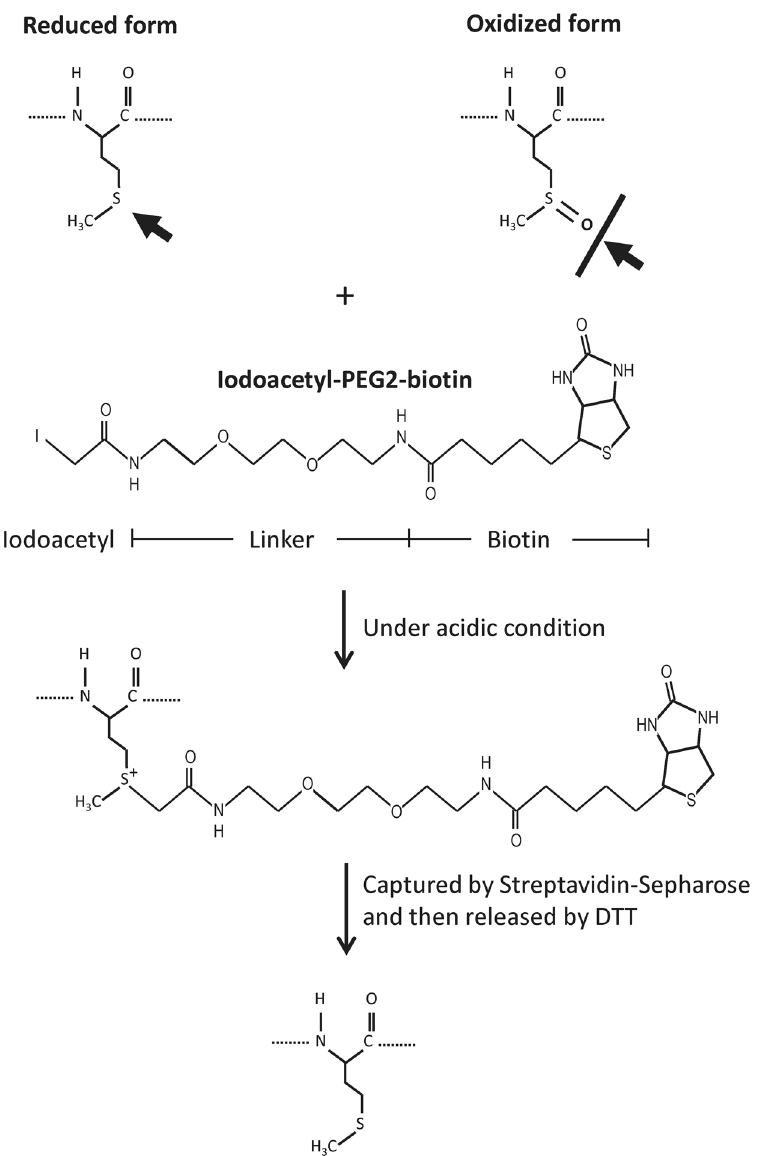
Figure 1. The scheme for Met-peptide enrichment. Reduced Met-peptides are labeled by the iodoacetyl-PEG2- biotin reagent under acidic conditions, whereas the oxidized Met-peptides are not. The labeled peptides are then captured and purified with streptavidin-Sepharose beads. After reduction by DTT, the captured Met-peptides are released from the beads and analyzed by